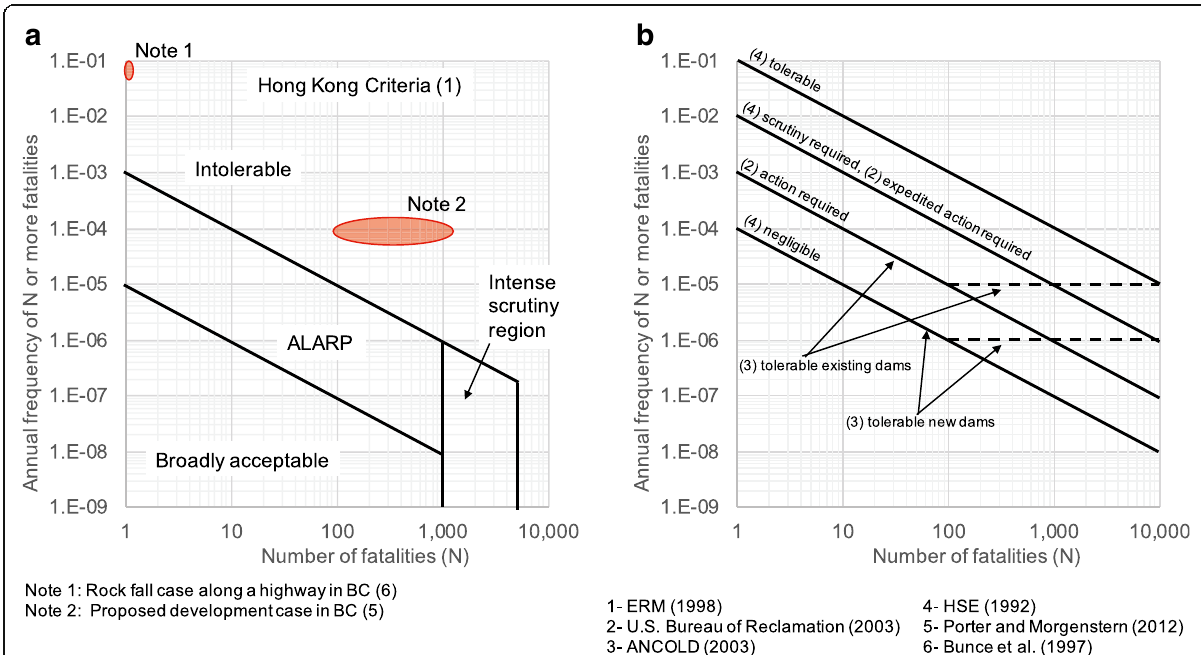
Fig. 5 Societal risk evaluation criteria. a Criterion proposed in Hong Kong for developments in landslide prone areas and cases where risks were found to be intolerable. b Criteria commonly cited in the